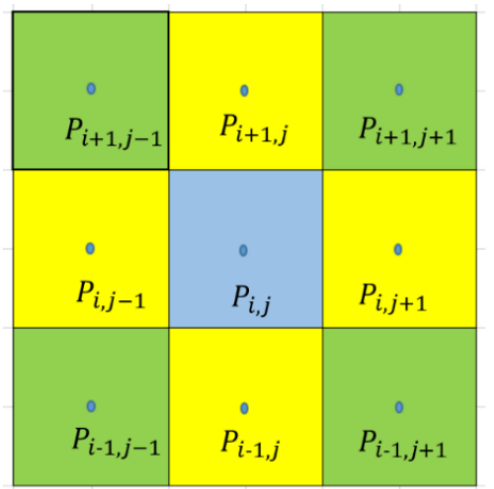
Figure 4. The relationship between the pixel to be amended and its adjacent pixels.